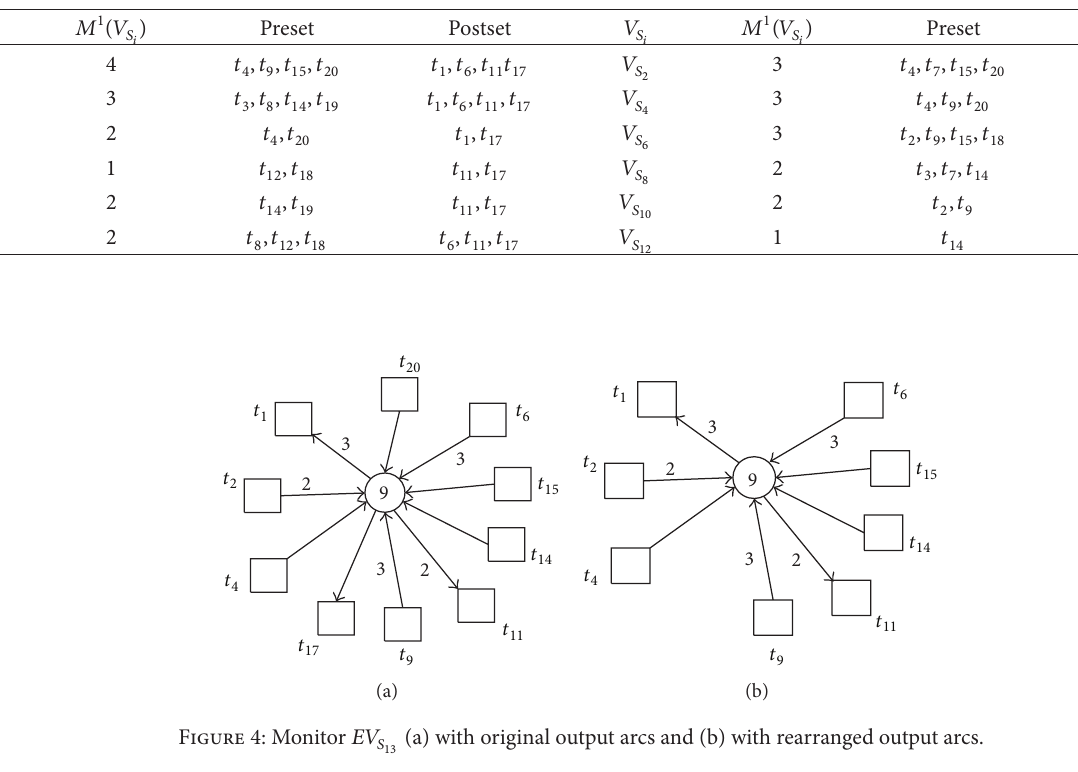
Table 1: Monitors added at the first phase.